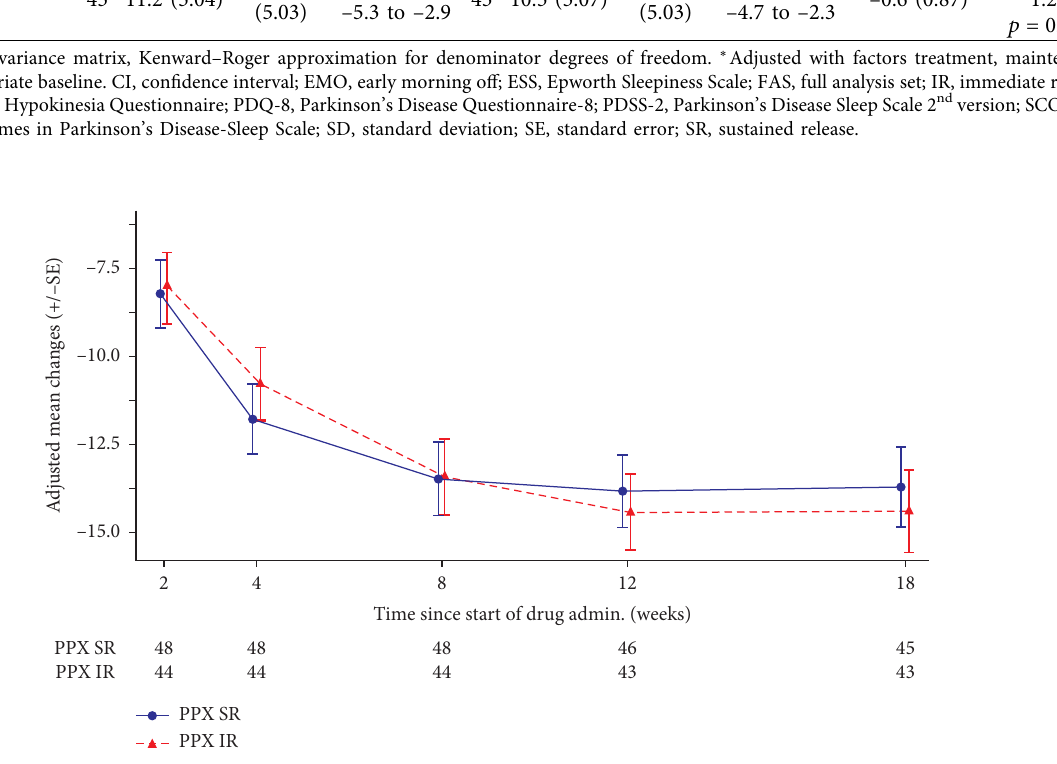
Figure 2: Adjusted mean changes from baseline in PDSS-2 over time in titration/maintenance period (FAS). Adjusted with factors treatment, titration/maintenance period, and covariate baseline. The current trend is consistent with the planned primary analysis for mean changes from baseline in PDSS-2 over time, which adjusted with factors treatment, maintenance phase and covariate baseline. Unstructured covariance matrix, Kenward–Roger approximation for denominator degrees of freedom. FAS, full analysis set; IR, immediate release; PDSS- 2, Parkinson’s Disease Sleep Scale 2 nd version; PPX, pramipexole; SE, standard error; SR, sustained